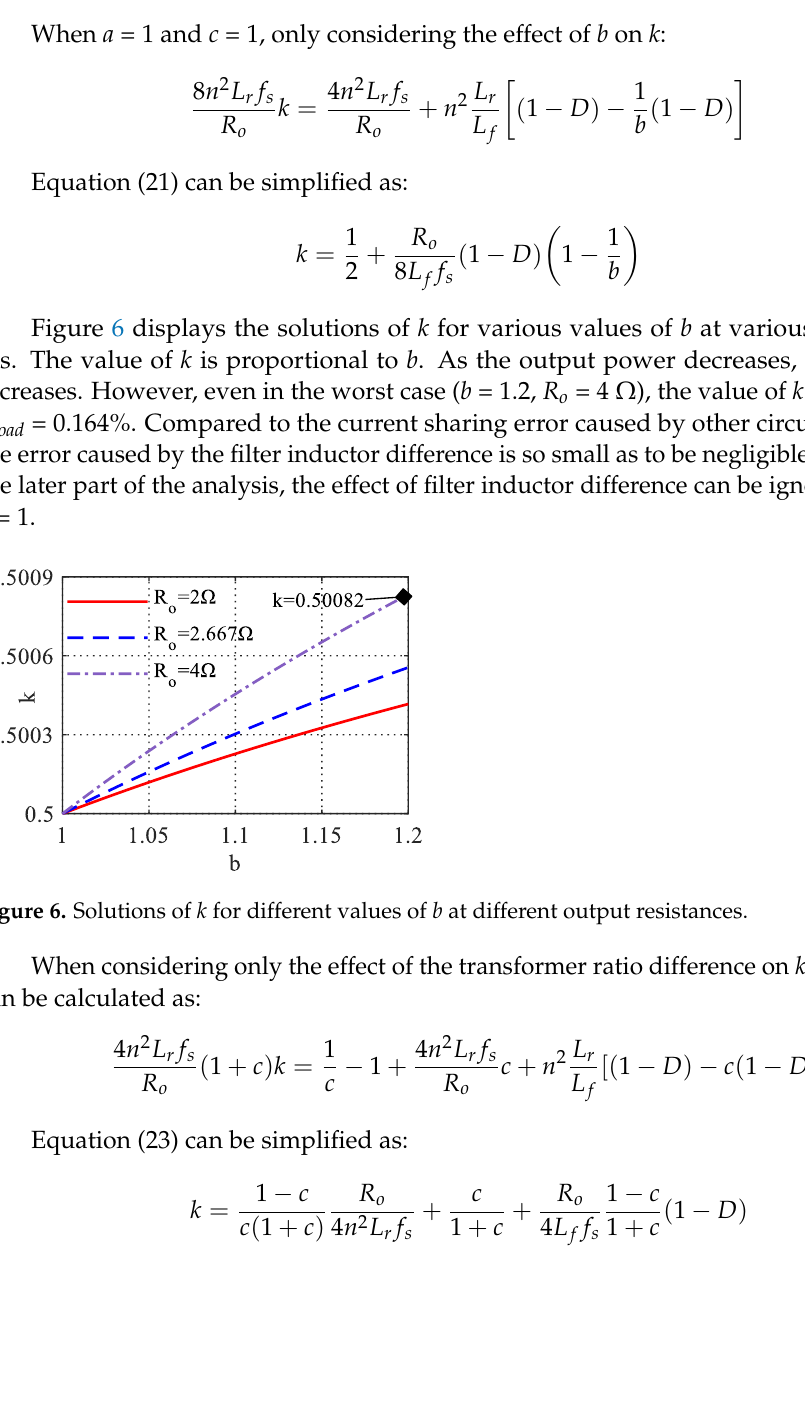
P = 800 W). R = 2  , o o